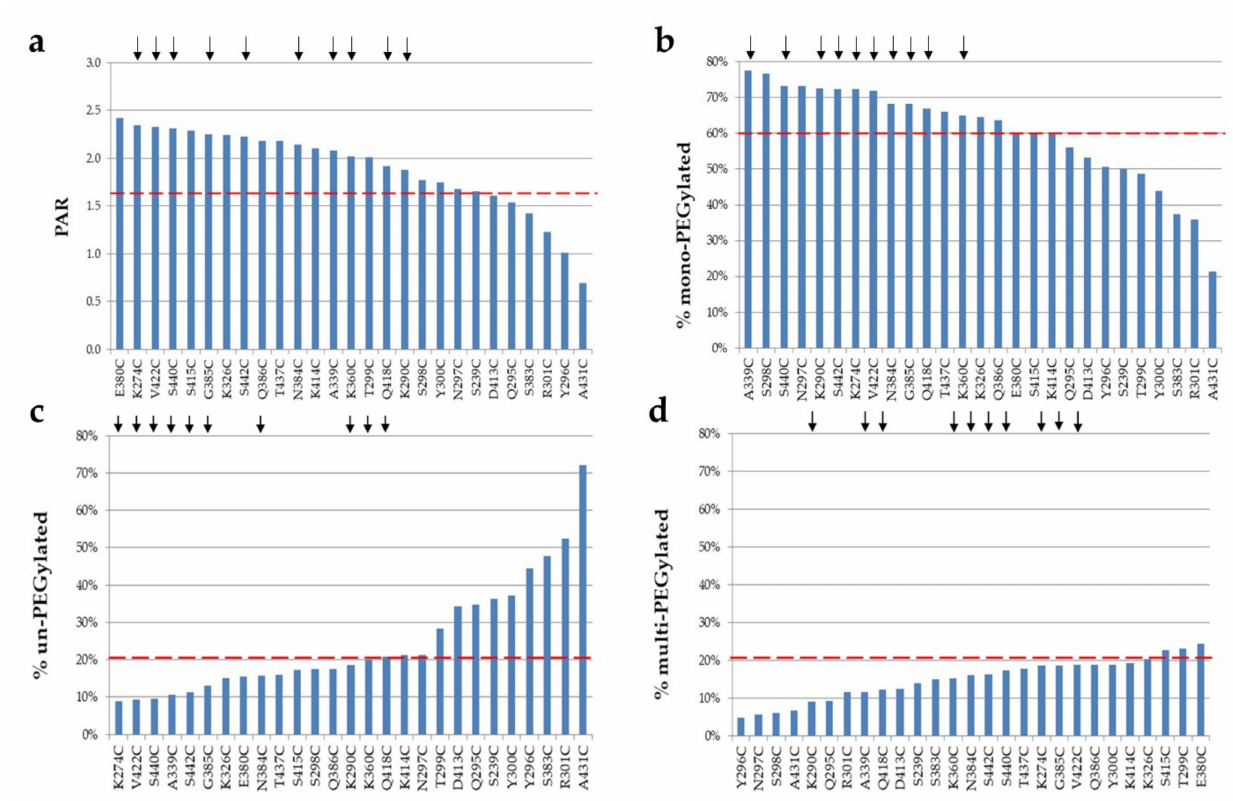
Figure 3. Different conjugation efficiency and selectivity observed among the unpaired single cysteine mutants. The Coomassie blue stained SDS-PAGE reducing gels were scanned using ProteinSimple. The PAR ( a ) and percentages of mono- PEGylated ( b ), un-PEGylated ( c ), and multi-PEGylated ( d ) antibody bands were determined with AlphaView software [29]. The red dot lines represent cut offs, and arrows represent top ten single cysteine